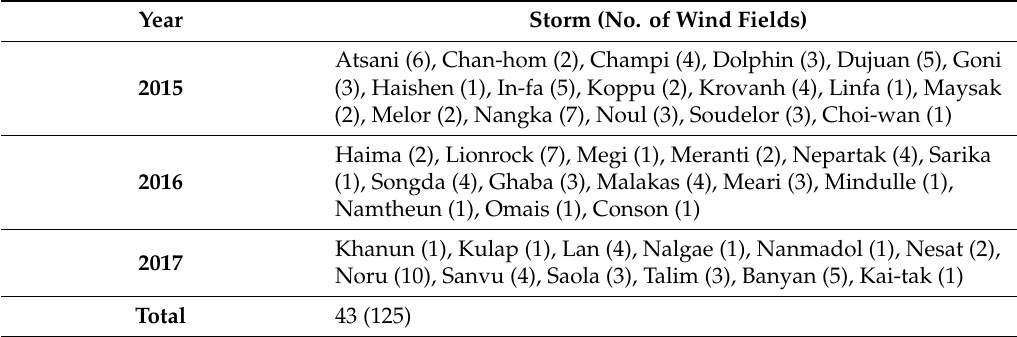
Table 1. Names of TCs and corresponding numbers of SMAP wind field snapshots. The year in which each storm occurred is also shown in the table. Storm (No. of Wind